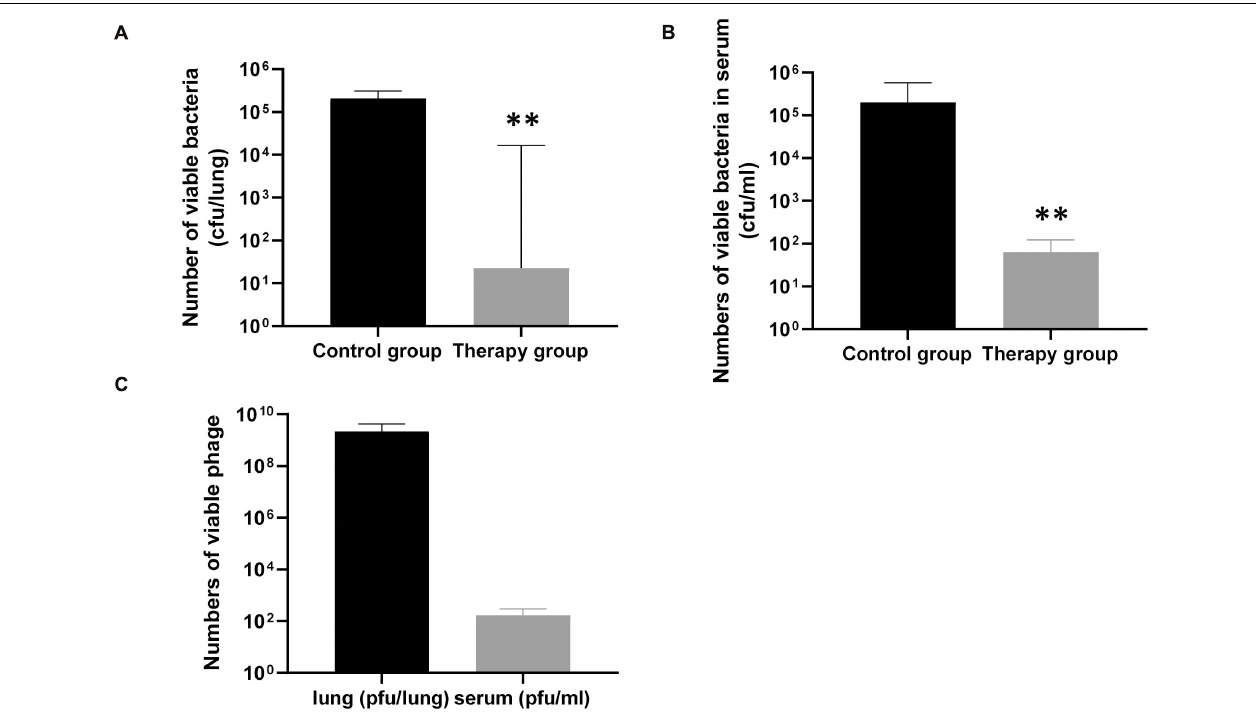
FIGURE 3 | The number of viable bacteria and phage in the lungs and serum of mice 24 h after infection. The number of viable bacteria in the lungs (A) , the phage treatment group ( n = 6) was significantly lower than that of the control group ( n = 6). The number of viable bacteria in the serum (B) , the phage treatment group ( n = 6) was also significantly lower than that of the control group ( n = 6). Data are presented as mean ± SEM of two experiments. The number of viable phages in the lungs and serum (C) of phage-treated mice 24 h after infection. Data are presented as mean ± SEM of two experiments (** < 0.01 vs. untreated control). CFU denotes colony forming unit. PFU denotes plaque forming